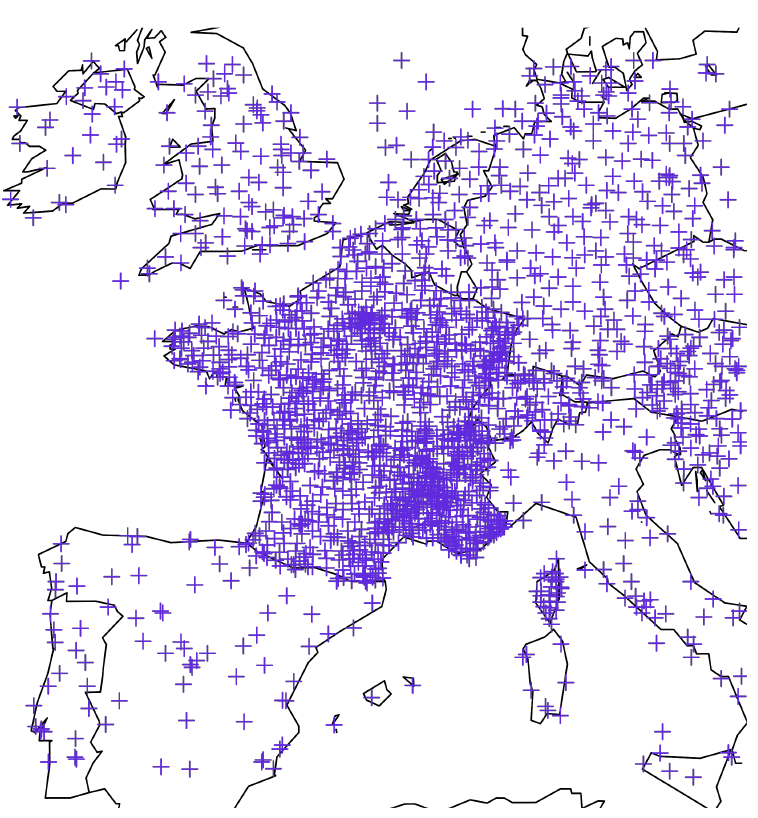
Figure 1. Location of the 2056 stations of this